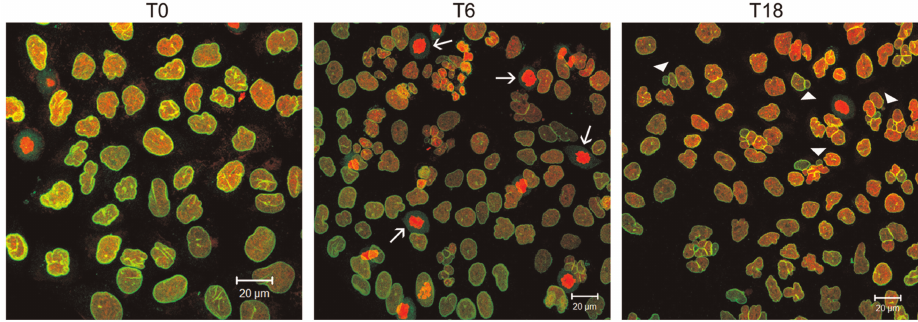
Figure 3. Effects of double blockade in A549 cells. Nuclear morphology observed in A549 cells at different times of recovery after vincristine exposure: c-mitoses with condensed chromatin are observed immediately after vincristine removal (T0); in high frequency in T6 (arrows); the highest frequency of micronuclei observed in T18 (arrowheads). The lamin B labeling (green) allowed the evaluation of nuclear envelope integrity in both main nucleus and micronucleus. DNA was stained with propidium iodide (red). Images are projections of different slices obtained by laser scanning confocal microscopy. T: times of recovery after vincristine removal (0, 6, and 18 h).